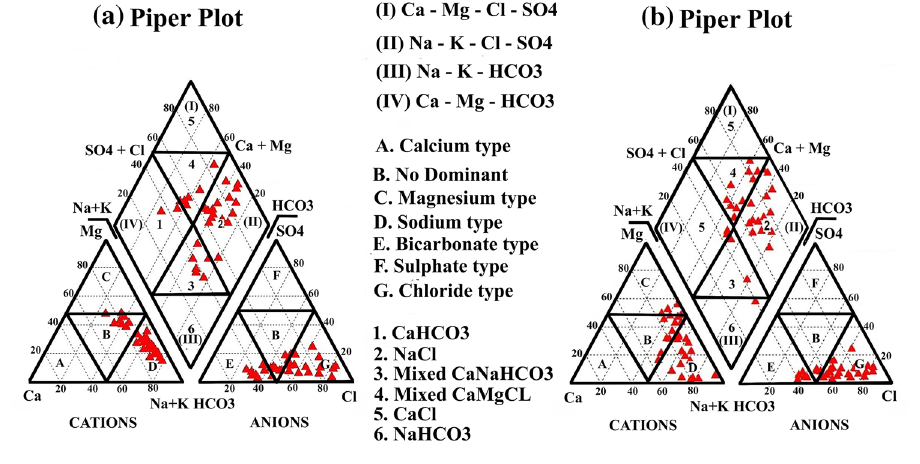
Fig. 9 Piper plot describing hydrogeochemical facies of the study area: a January, b June